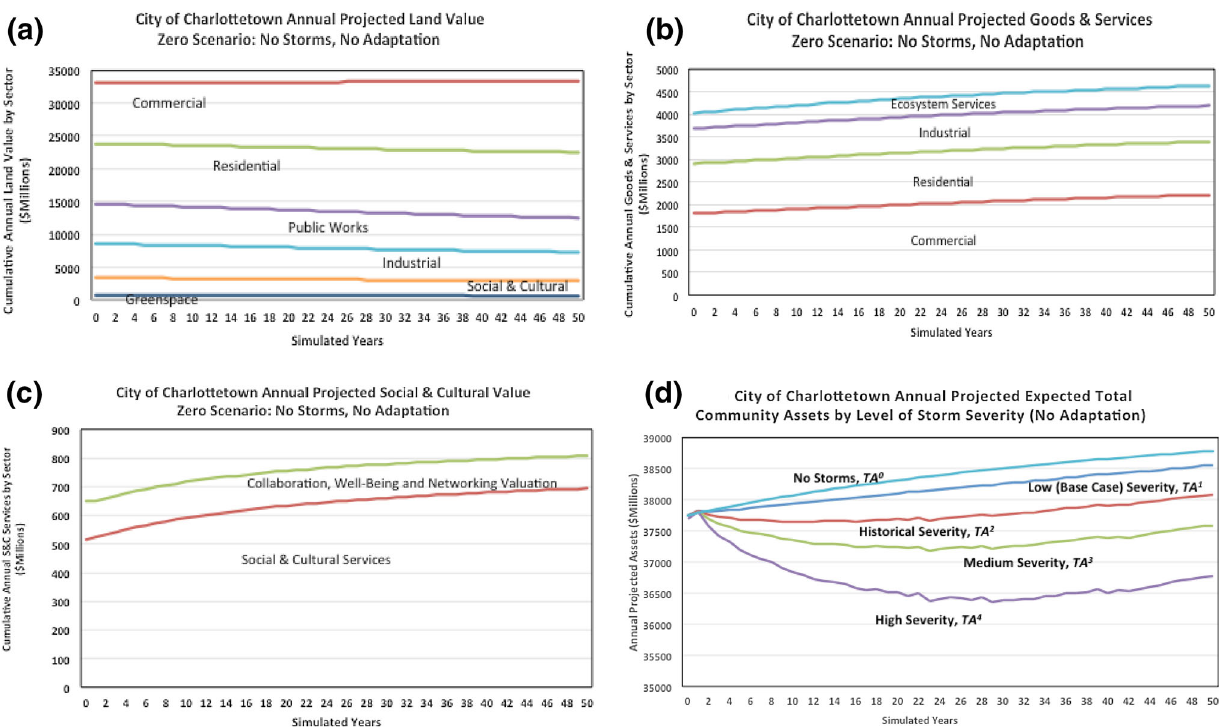
Fig. 4 Charlottetown, Prince Edward Island, No Storm scenario SD model results: a Environmental (Land Value); b Economic (Goods and Services); c Social and Cultural (Services and Social Mapping